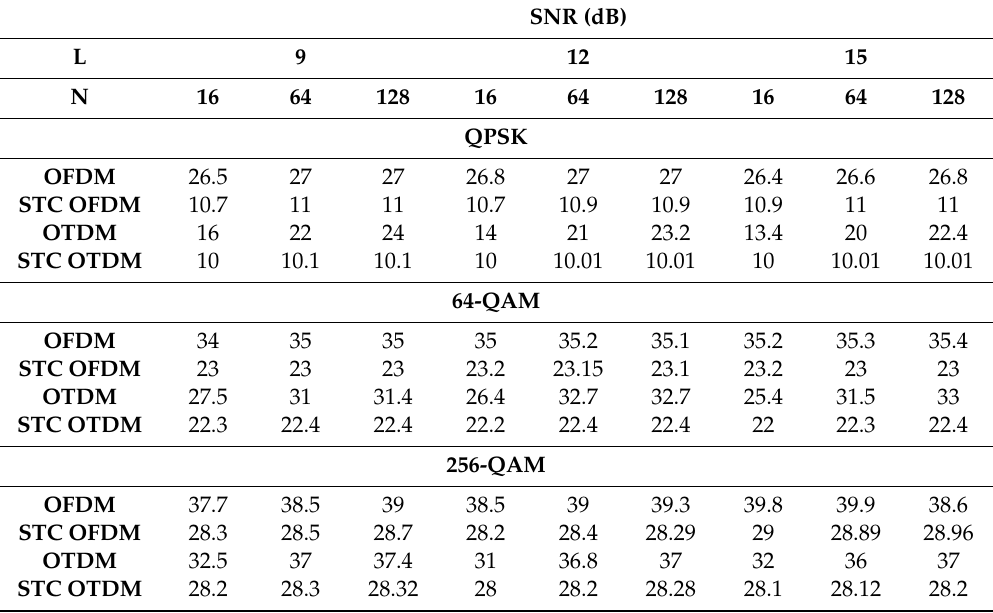
Table 2. The SNR (dB) simulation results at BER = 10 − 3 for di ff erent modulation schemes, di ff erent subcarriers, and channels models.